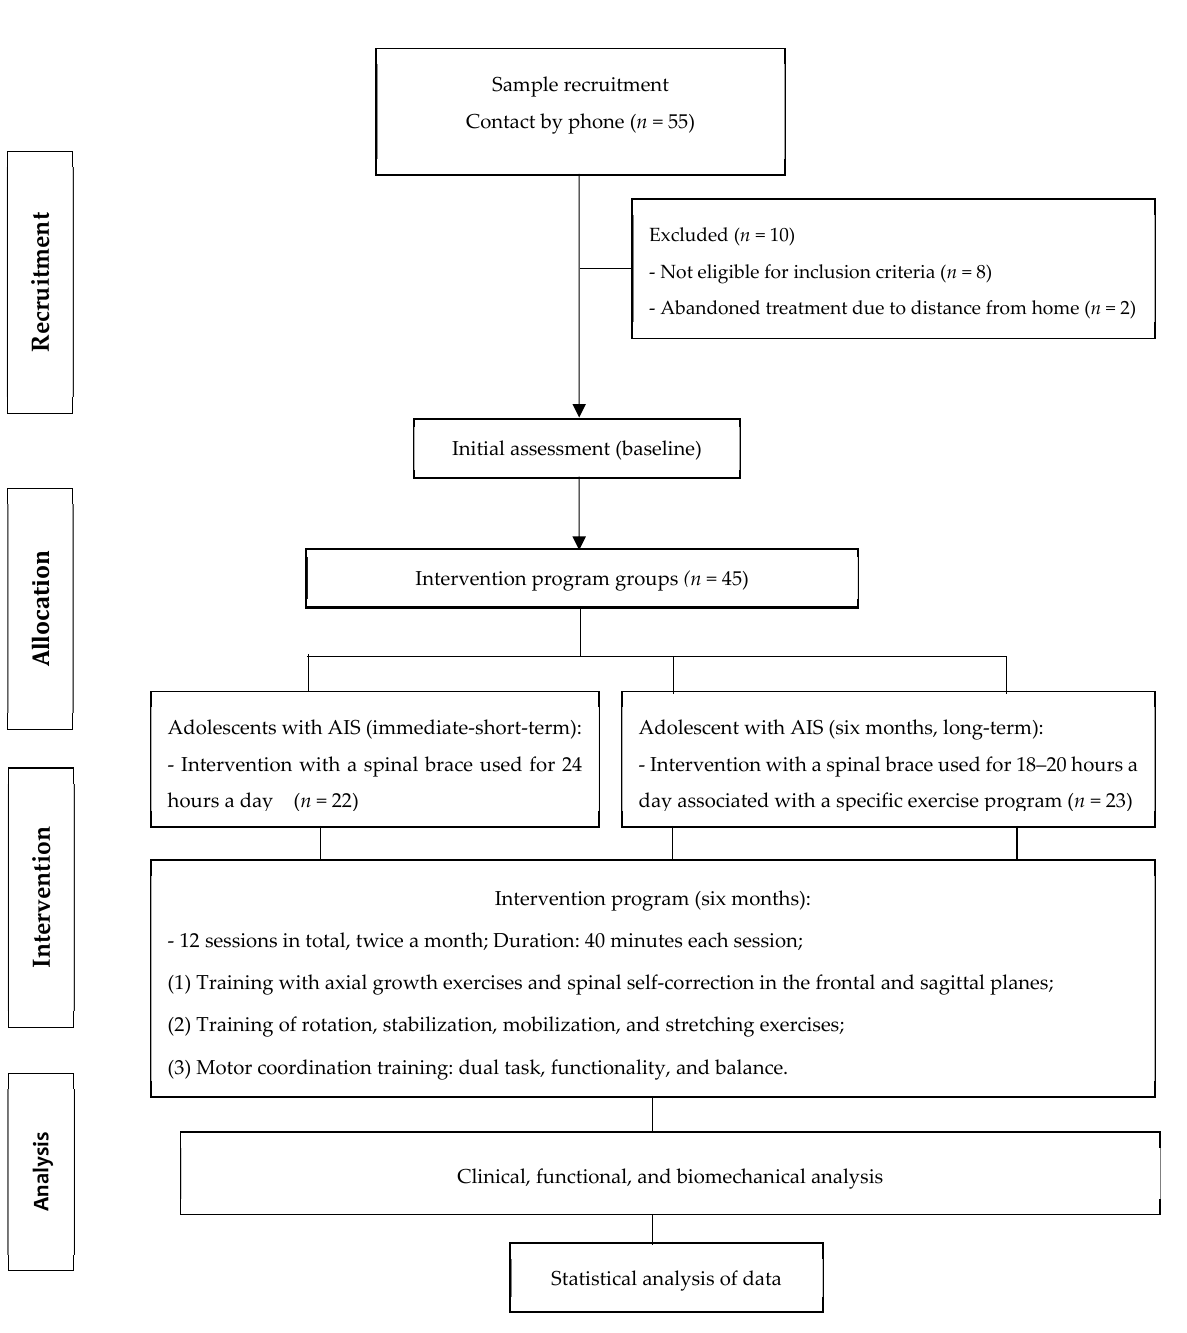
Figure 1. Intervention Protocol in adolescents with AIS.